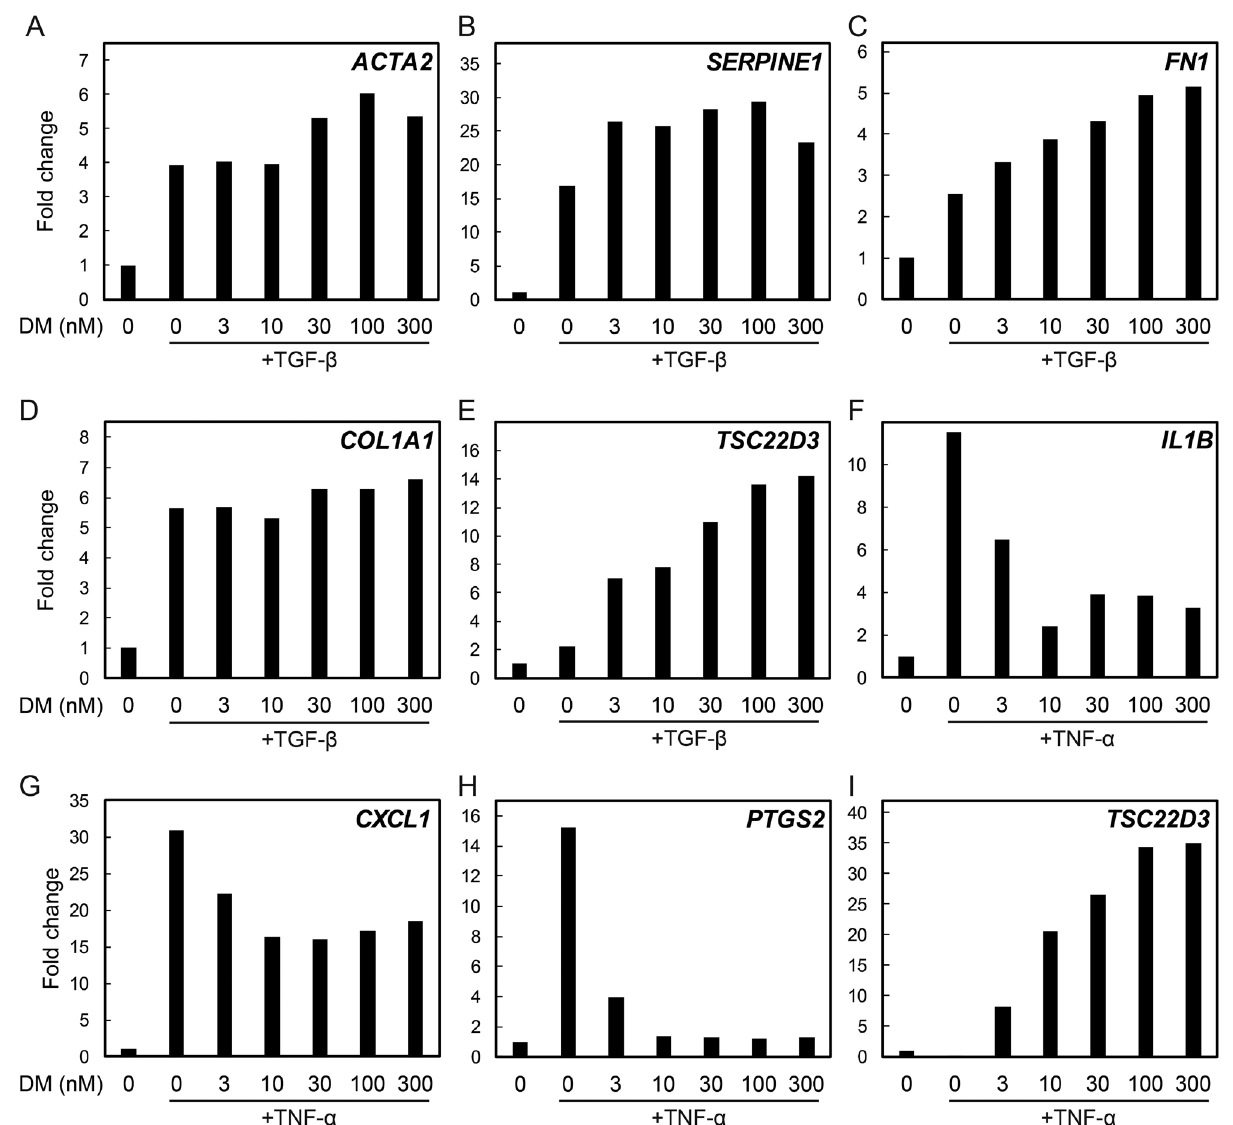
Figure 3. Fibrotic, inflammatory, and TSC22D3 genes expression in human vocal fold fibroblasts after treatment with TGF-β1, TNF-α, and dexamethasone. HVOX cells were treated with TGF-β1 (TGF-β; 10 ng/ mL), TNF-α (10 ng/mL), and dexamethasone (DM; 0-100 nM) alone or in combination for 24 h ( A , B ), and ACTA2 ( A ), SERPINE1 ( B ), FN1 ( C ), COL1A1 ( D ), TSC22D3 ( E , I ), IL1B ( F ), CXCL1 ( G ), PTGS2 ( H )